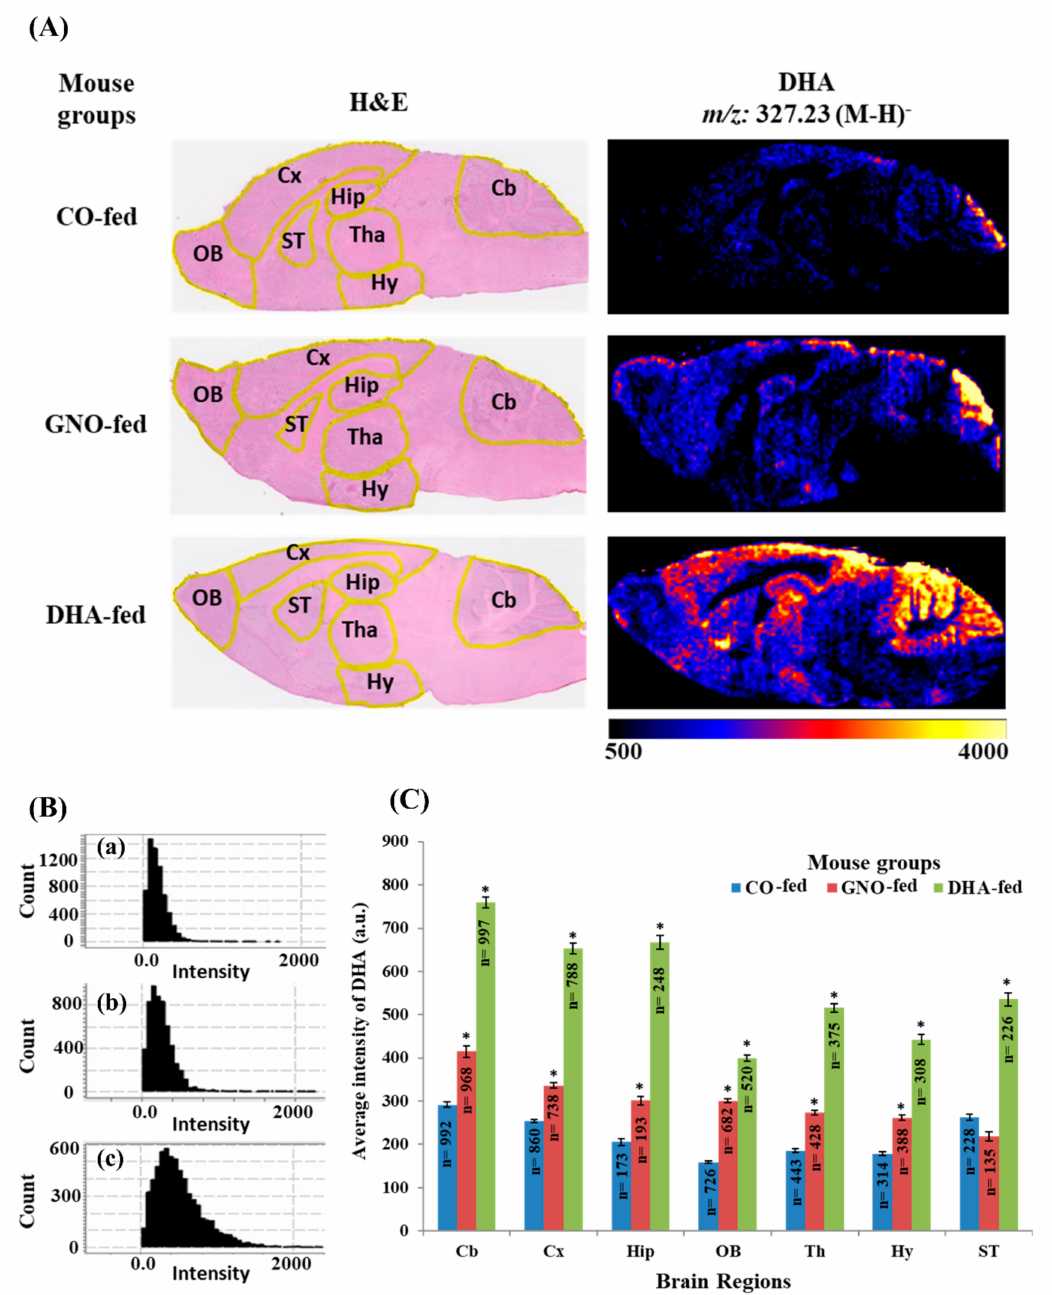
Figure 4. Distribution of DHA in di ff erent parts of the sagittal sections of SAMP8 mouse brains. CO-fed, GNO-fed, and DHA-fed indicate corn oil-fed SAMP8 mice, green nut oil-fed SAMP8 mice, and DHA-fed SAMP8 mice, respectively. ( A ) represents H&E stained brain slices and ion images of DHA. ( B ) represents the distribution of the signal intensity of DHA in SAMP8 mouse brains after supplementation with CO ( a ), GNO ( b ), and DHA ( c ). ( C ) represents average intensity (a.u.) of DHA in the di ff erent regions of SAMP8 mouse brains after supplementation with CO, GNO, and DHA. Here * indicates p < 0.001 compared to CO-fed SAMP8 mice. All values are expressed as mean ± SEM. Cb: cerebellum, Cx: cerebral cortex, Hip: hippocampus, OB: olfactory bulb, Tha: thalamus, Hy: hypothalamus, ST: septum, n: number of